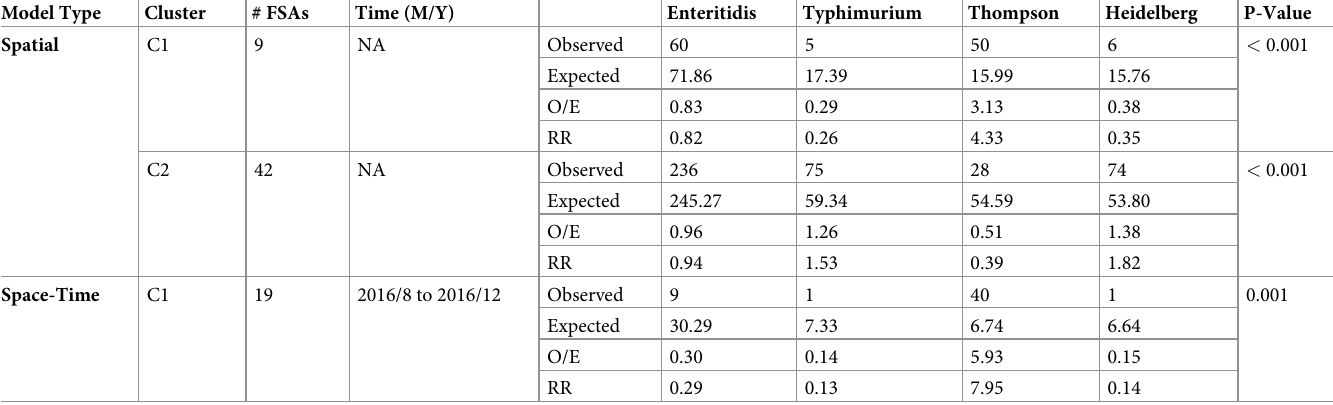
Table 2. Spatial and space time clusters of major nontyphoidal Salmonella enterica serotypes identified by the multinomial scan statistic in Toronto, Canada, 2015–2017 1 . Model